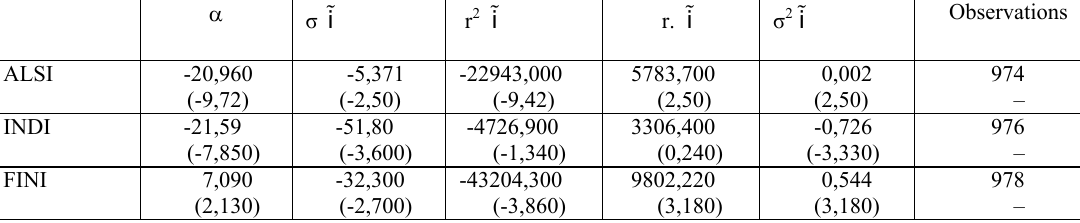
Table 7: Daily regressions of basis on interest rate